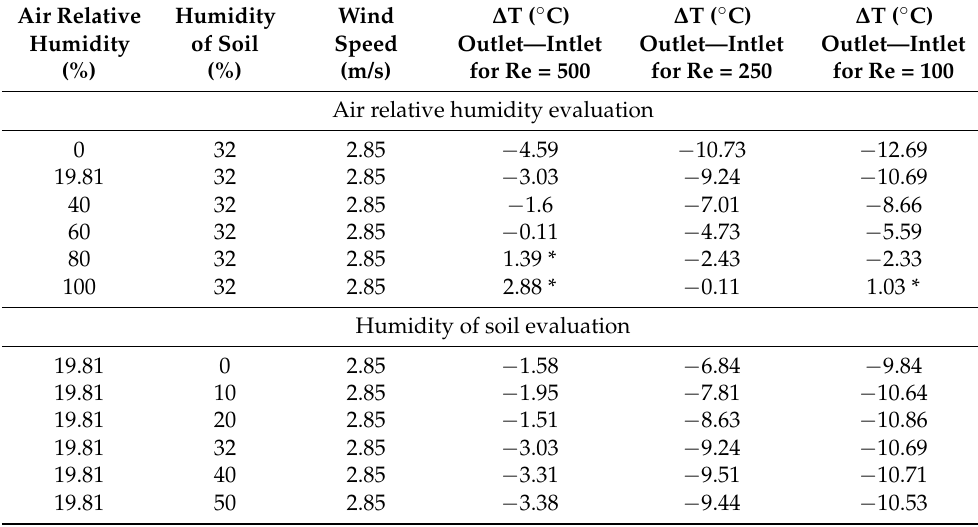
Table 13. Numerical evaluation of the cooling potential according to the climatological conditions of the